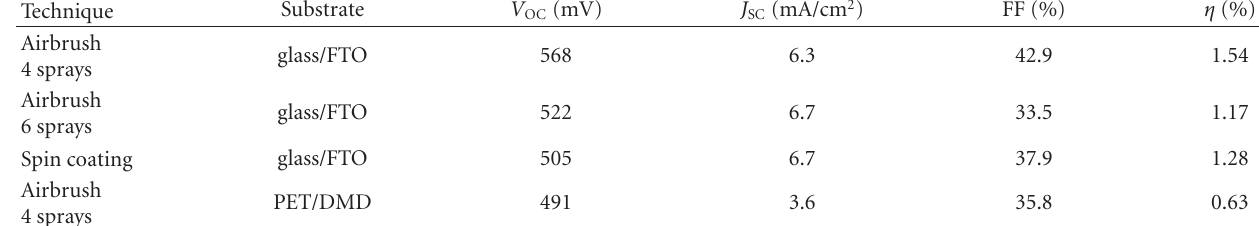
Table 1: Photovoltaic parameters of the device fabricated on glass/FTO and PET/DMD.